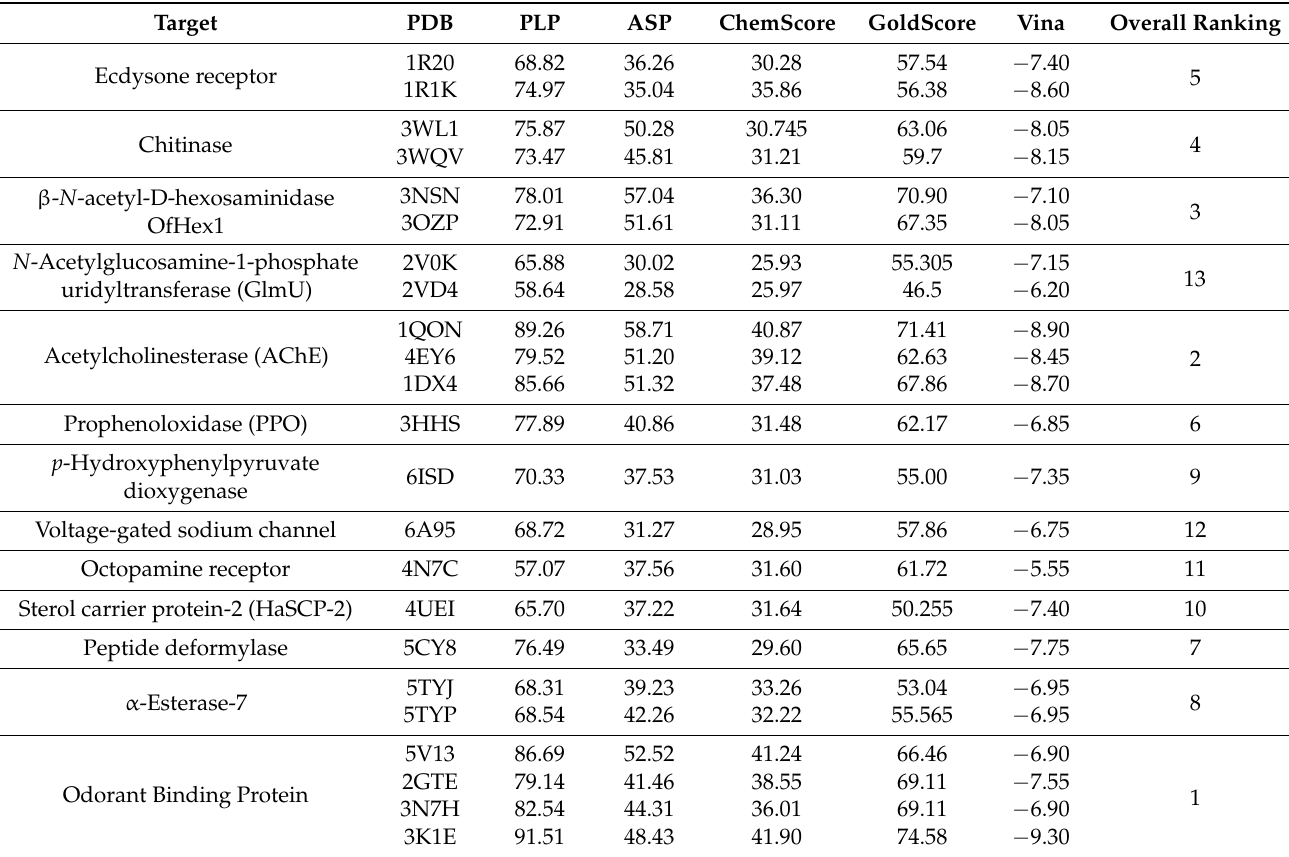
Table 1. Average scores of the amino alcohol derivatives of eugenol obtained for all PDB structures with the five different scoring functions and overall ranking of the most likely protein targets for interaction.